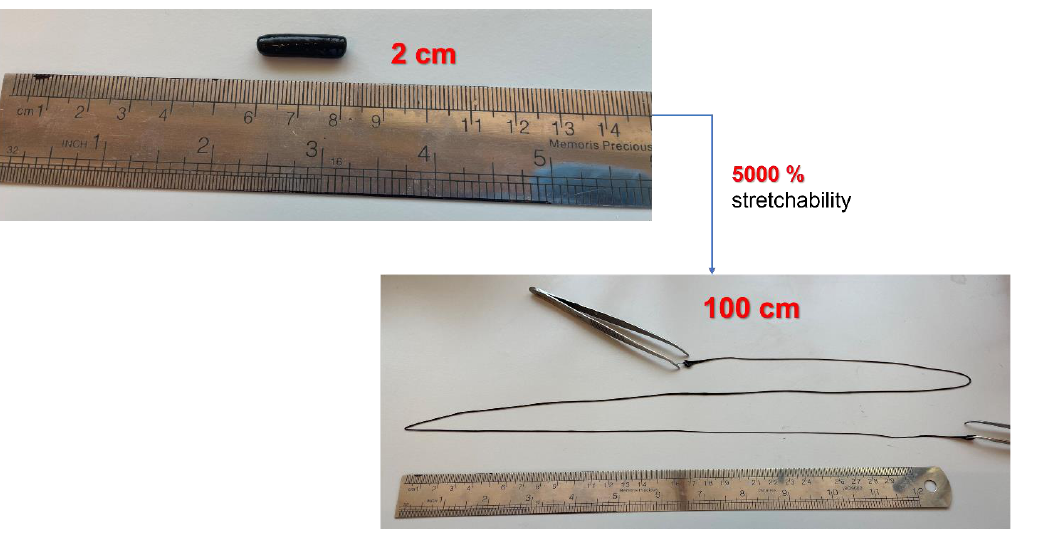
Figure 7. Extreme stretchability observed for the sample PVA/Xan + 5 wt.% ACB.